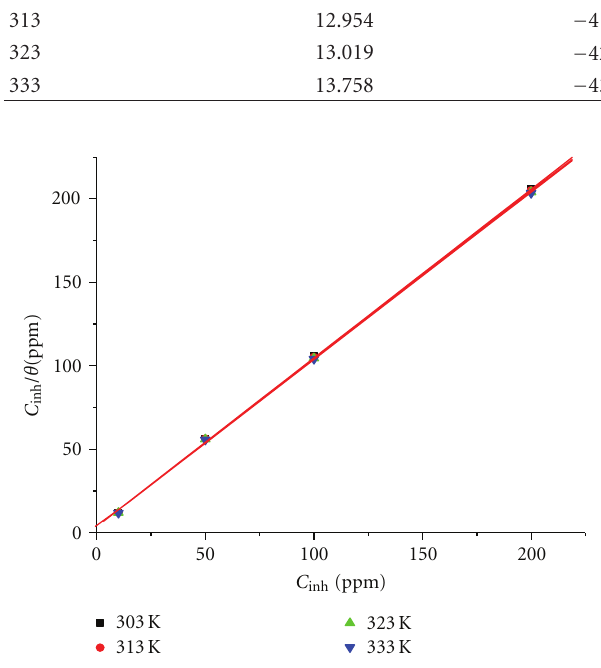
Figure 7: Langmuir adsorption isotherm for mild steel in 1M HCl solution at 30 ◦ C.